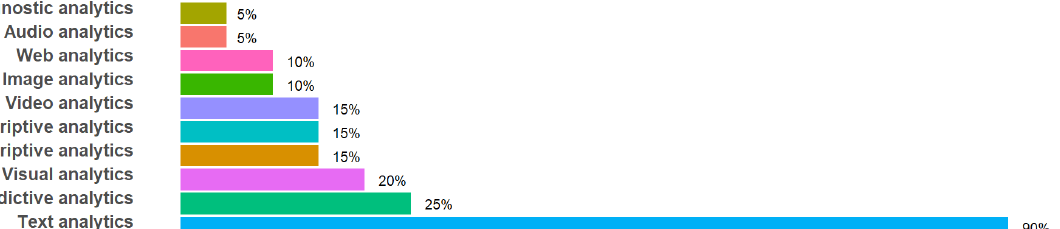
Fig. 6 Utilization of social data